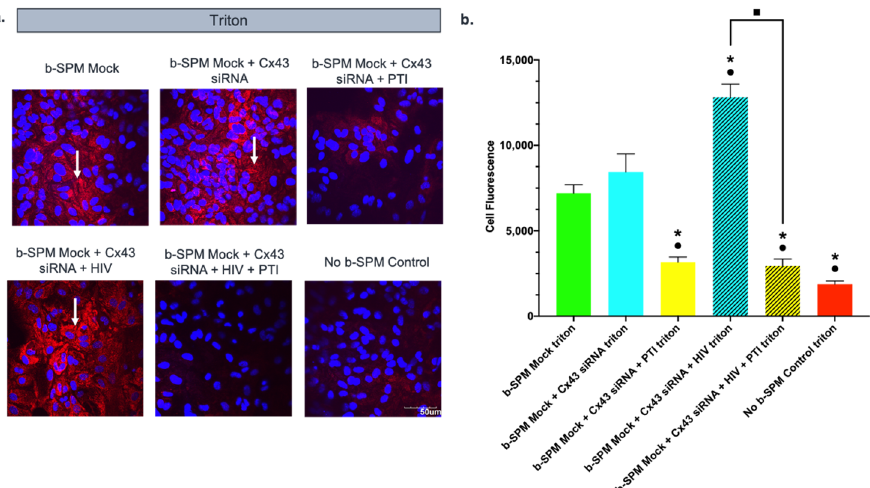
Figure 5. PTI significantly reduced the enhanced b-SPM uptake in b-SPM siRNA and HIV-Tat-treated astrocytes. Rho-avidin was used to visualize b-SPM (red), and DAPI was used to visualize the nuclei (blue). The presence of b-SPM presence is marked with the white arrows. ( a ) Qualitative representation of the data. Mock (only treated with HiPerFect) and mock + PTI astrocytes were incubated in either 80 µ M of b-SPM or no b-SPM (PBS). No b-SPM samples were used as negative control. Calibration bar is the same for all images (50 µ m). ( b ) Quantitative representation of the data ( n = 3/group). Asterisks (*) indicate statistically significant differences ( p < 0.05) with the b-SPM mock triton group. Black circles ( • ) indicate statistically significant differences ( p < 0.05) with the b-SPM mock + Cx43 siRNA triton group. Black squares ( (cid:4) ) indicate a statistically significant difference ( p < 0.05) between the b-SPM mock + Cx43 siRNA + HIV triton and the b-SPM mock + Cx43 siRNA + HIV + PTI